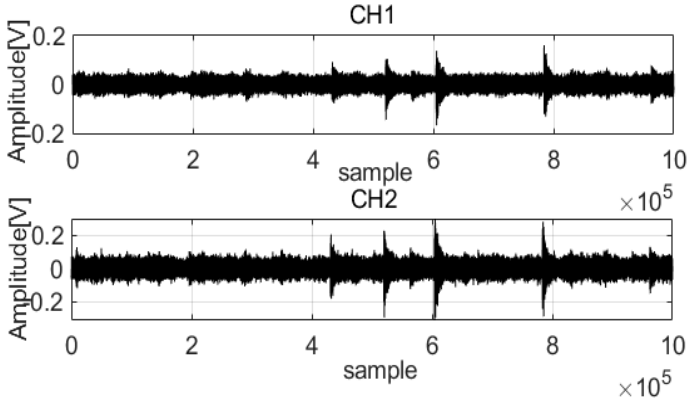
Figure 1. Acoustic waves of the two channels. The raw signals were processed by MED to remove noise. The two original signals are compared in Figures 2 and 3.